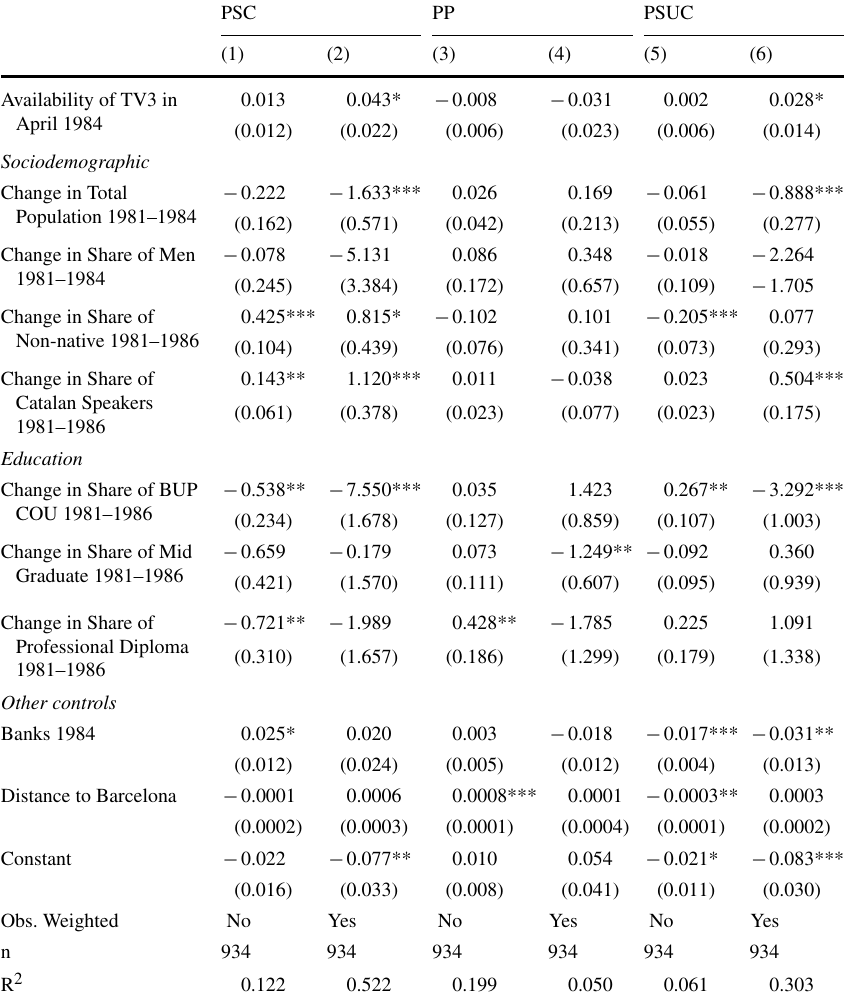
Table 3 Effect on the change in vote share in the 1980–1984 Catalan parliamentary elections of other political parties (PSC, PP and